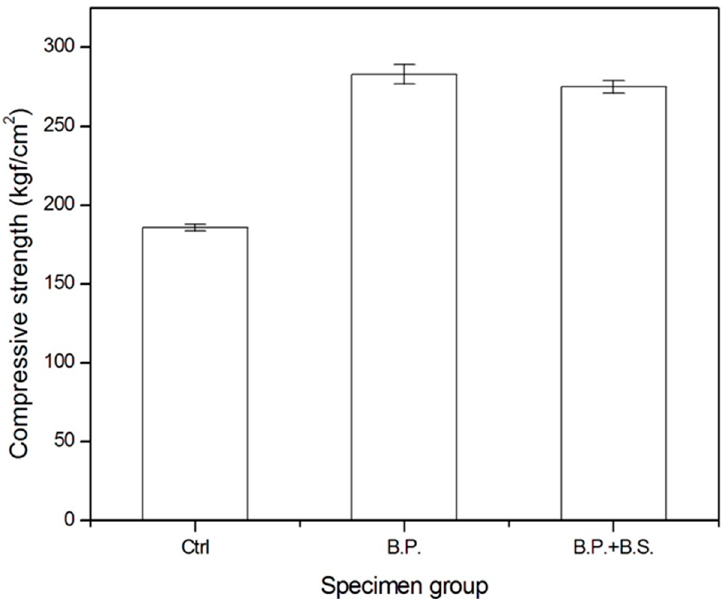
Figure 7. Test results of the compressive strength for the control, SP and SP + BS group specimen at 14 days.